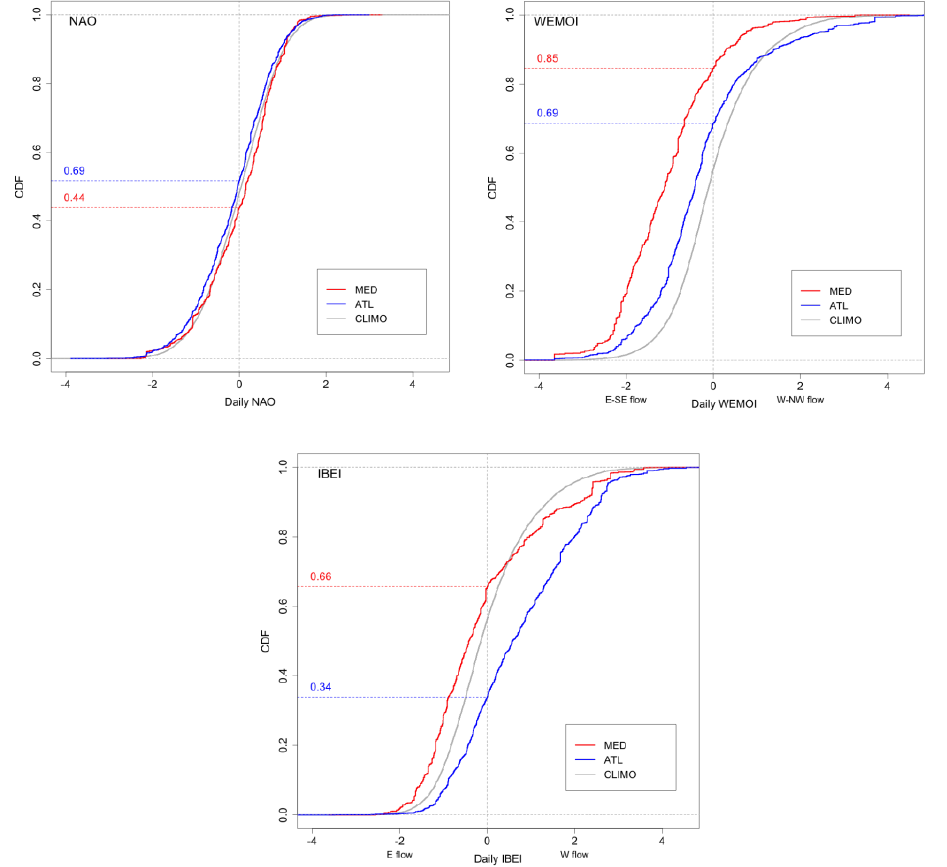
Fig. 8. Cumulative distribution functions of daily values corresponding to NAO, WeMOi and IBEI. Gray lines correspond to values from 1 January 1950 to 31 March 2013 for NAO and from 1 September 1957 to 31 August 2002 for WeMOi and IBEI. Red and blue lines Figure 8.- Cumulative distribution functions of daily values corresponding to NAO, WEMOI and IBEI. Gray lines correspond to the values of daily NAO, WeMOi and IBEI for MED and ATL extreme precipitation days, correspond to values from 01-01-1950 to 31-3-2013 for NAO and from 01-09-1957 to 31-08-2002 for WEMOI and IBEI. Red and blue lines correspond to the values of daily NAO, WEMOI and IBEI for MED and ATL extreme precipitation days, respectively.